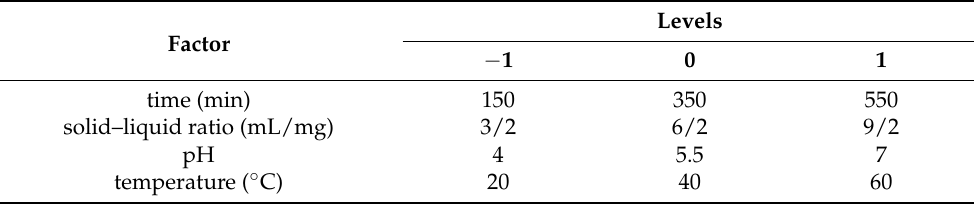
Table 7. Test factor level and coding table of the response surface method. Levels Factor − 1 0 1 time (min) 150 350 550 solid–liquid ratio (mL/mg) 3/2 6/2 9/2 pH 4 5.5 temperature ( ◦ C) 20 40